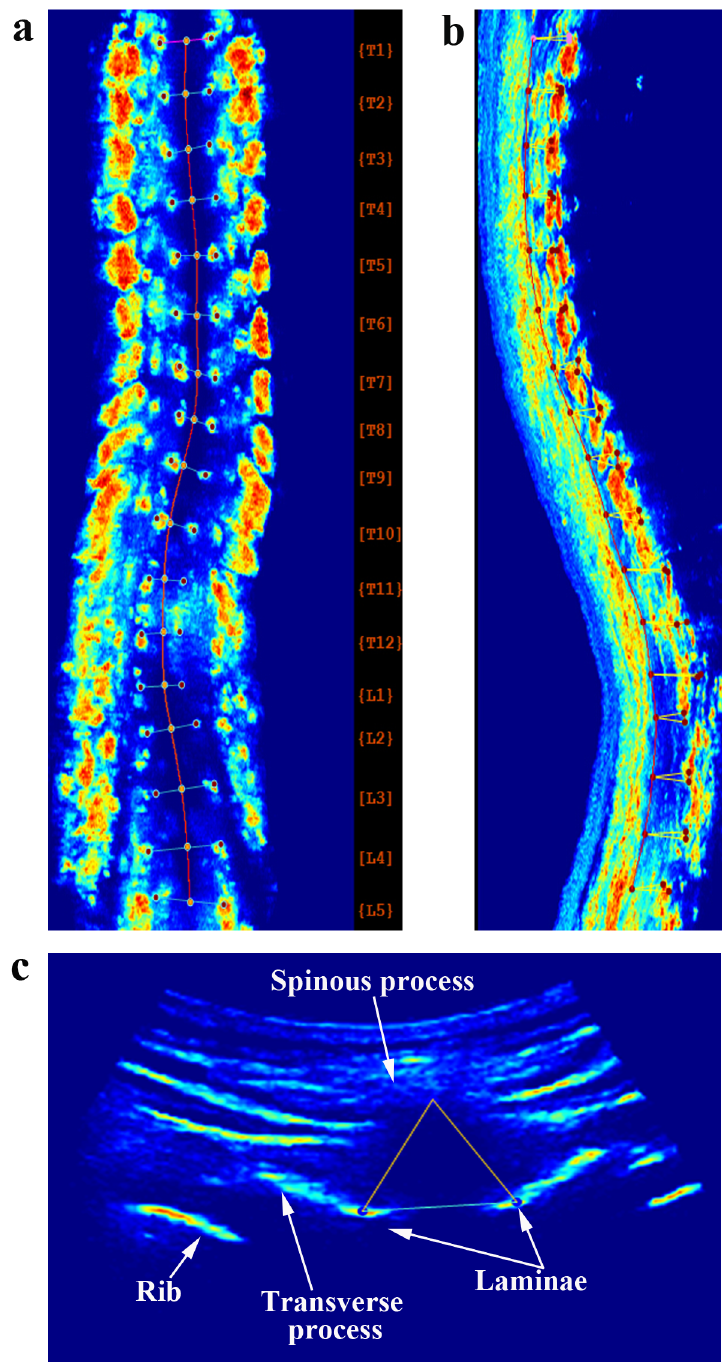
Fig 2. 3-D reconstructed ultrasound images of scoliotic spine. (a) Coronal plane; (b) Sagittal plane; (c) Transverse